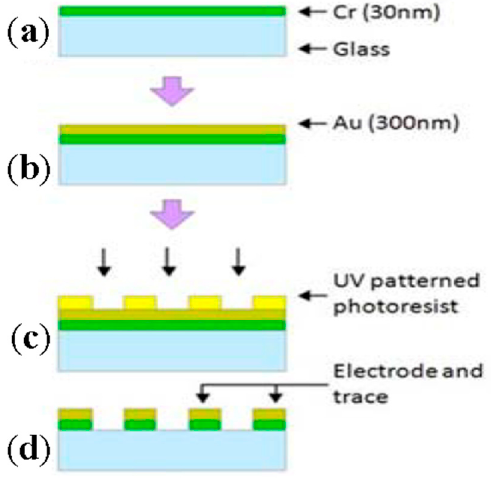
Figure 1. A typical fabrication procedure of the sensing substrate used in cell-based impedance (CBI) set up. ( a ) the glass surface is coated by 30 nm layer of Cr; ( b ) followed by a 300-nm layer of Au; ( c ) and ( d ) Au/Cr layer is subsequently photoetched into interdigitated electrodes. Adapted from Wang